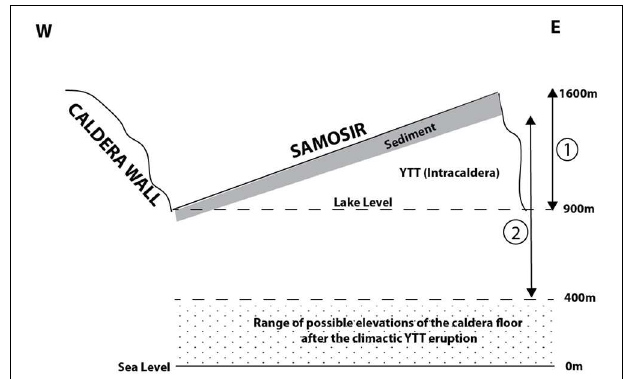
FIGURE 2 | Schematic cross section of Toba Caldera illustrating critical measurements and features for interpreting the resurgent uplift of Samosir. (1) is the 700m of uplift estimated since ∼ 33ka when the uppermost sediment must have been at lake level. (2) is the maximum uplift of 1100m if the caldera floor was at 400m a.s.l. after the YTT eruption ∼ 74ka (based on Chesner, 2012). We note that the caldera floor could have been as low as sea level ( Chesner, 2012). Vertical is to scale, horizontal is